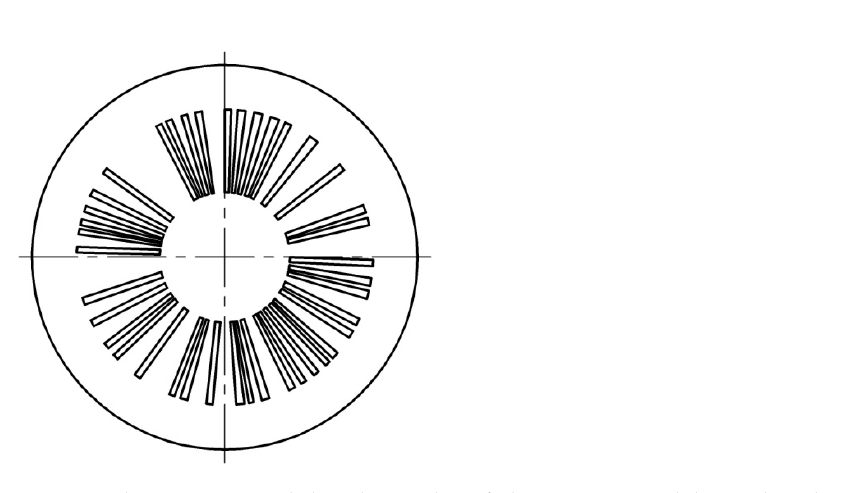
Figure 13. The single-rotor system spectrum with the quasi-trapezoidal modulation function and the number of places on the rotor disk m = 276.